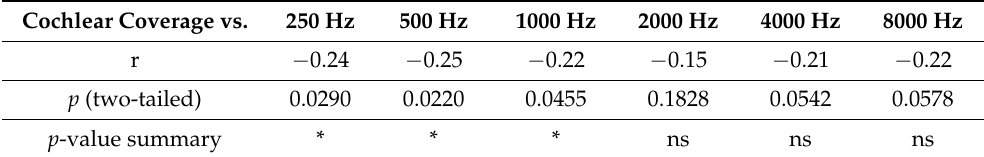
Table 2. Results of the correlation between cochlear coverage and each frequency. Cochlear Coverage vs.